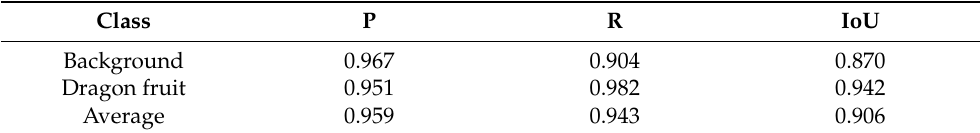
Table 4. Test results of PSPNet.